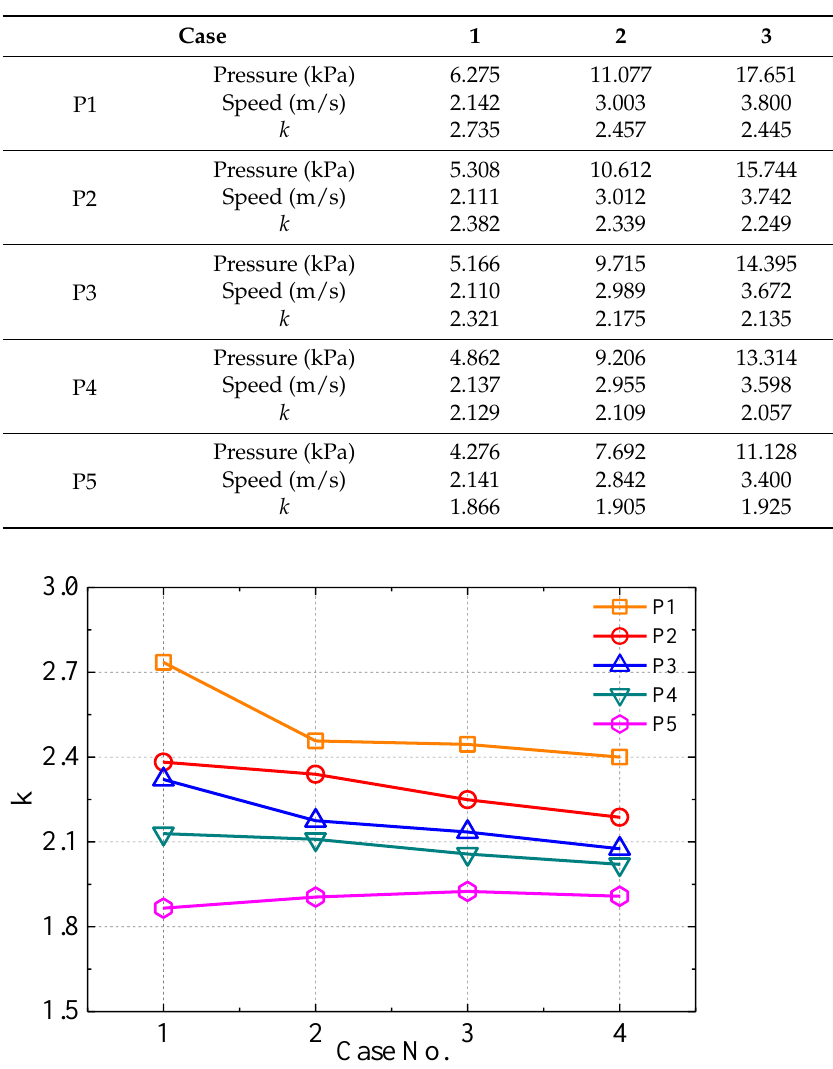
Figure 27. Distribution of dimensionless impact factor k . Table 11. Summary of impact pressure results.